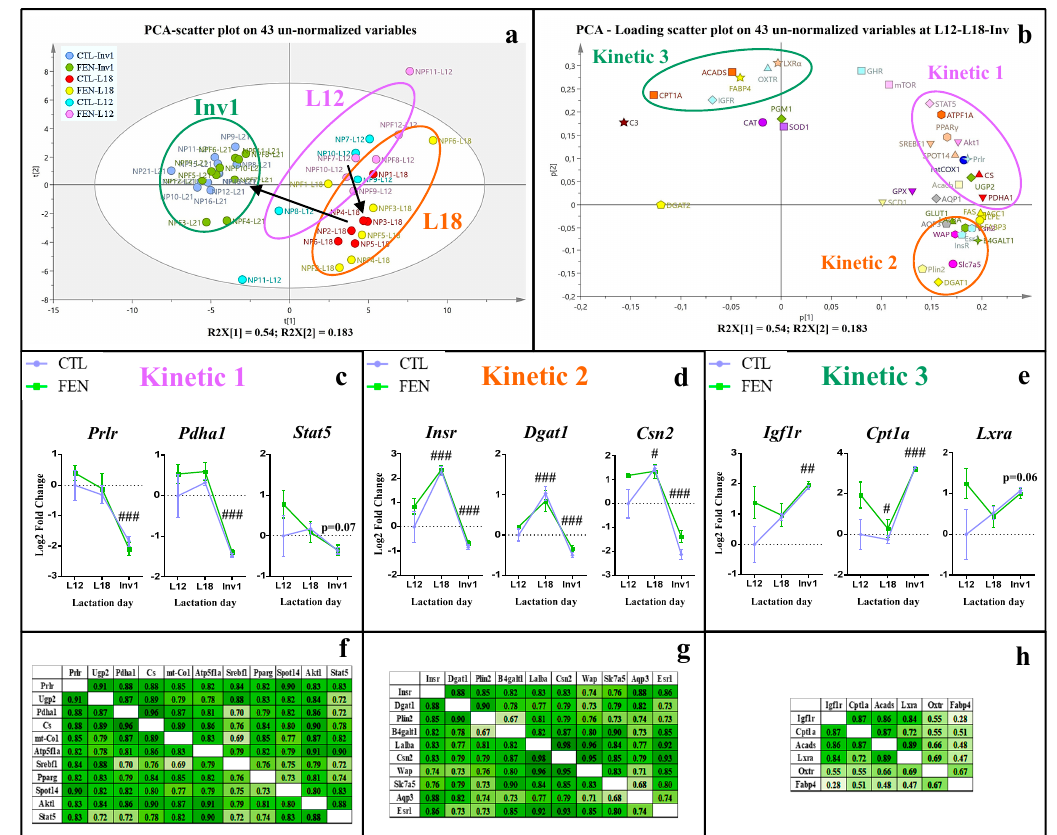
Figure 2. Temporal pattern of mammary gland gene expression in CTL and FEN groups through lactation and until involution. ( a ) Score plot on the first two dimensions of the PCA, accounting for 71% of the total variance for 43 un-normalized data (genes), ( b ) PCA loading plot presented clusters of variables highly associated to L12- and L18-groups (kinetic 1 and 2 clusters) or to Inv1 group (kinetic 3 cluster). Temporal pattern expression of representative genes of kinetic 1 ( c ), kinetic 2 ( d ) and kinetic 3 ( e ) clusters. Values were mean ± SEM and were analyzed with 2-way ANOVA followed by Tukey’s post-hoc tests. #: p < 0.05, ##: p < 0.01, ###: p < 0.001 for comparison with previous period. Correlations between gene expression in cluster 1 ( f ), 2 ( g ) and 3 ( h ) were analyzed with Pearson tests. The shade of green corresponds to the strength of the correlation between the variables with a light green for a weak correlation and a dark green for a strong correlation. CTL: control diet group and FEN: fenugreek-supplemented diet group throughout the lactation period. L12 and L18: post-natal day of lactation 12 and 18, InV1: first day of